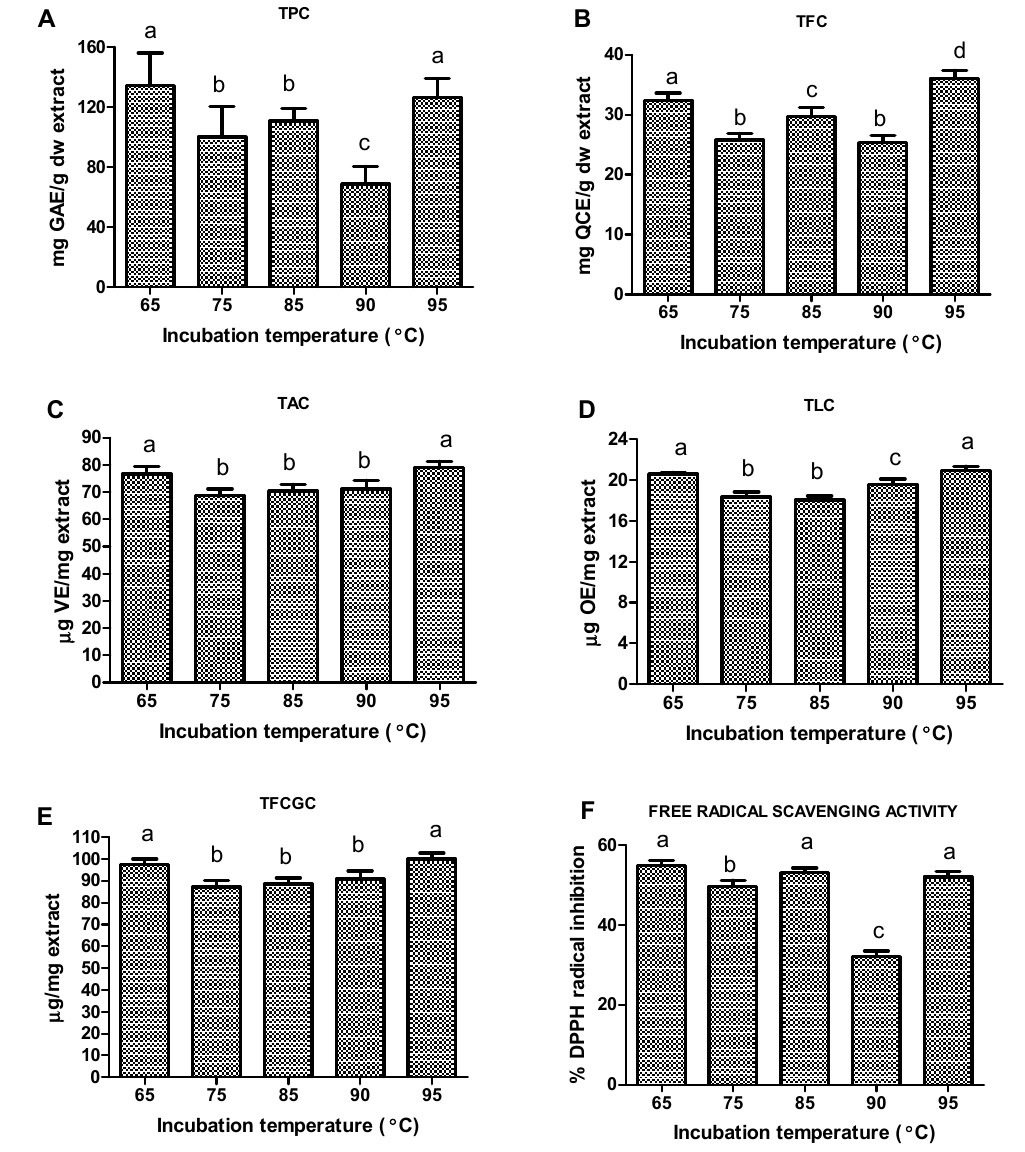
Figure 9. Effects of incubation temperature on acid hydrolysis for TPC ( A ), TFC ( B ), TAC ( C ), TLC ( D ), TFCGC ( E ), and DPPH free radical scavenging activity ( F ). Different letters indicate significant difference between tested parameters ( p < 0.05). DW stands for dried weight.